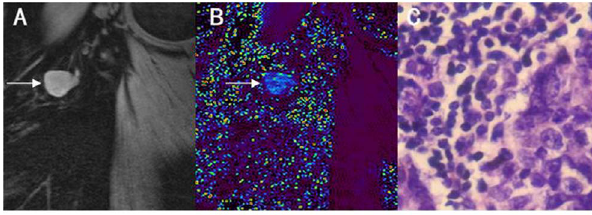
Figure 5. Metastatic lymph node in a 51-year-old woman. A: T2*WI, B: T2* map, with black representing the lowest T2* value and red representing the highest T2* value. C: corresponding histology image. The metastatic lymph node displays higher signal intensity than background on the T2* map.